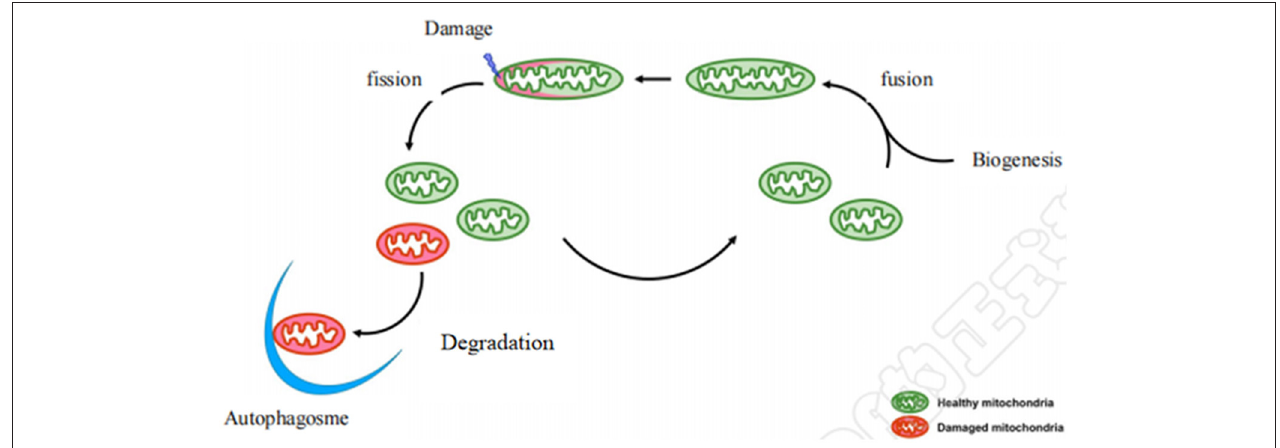
FIGURE 1 | Diagram of mitochondrial dynamics. Mitochondrial biogenesis is the process by which new mitochondria are formed in the cell after mitochondrial fusion. Mitochondrial biogenesis is activated by numerous different signals which can lead to mitochondrial fission and damaged mitochondria are degraded by autophagy.